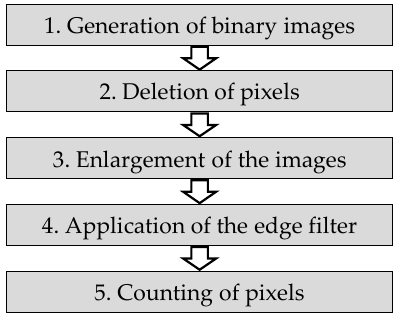
Figure 2. Steps of the developed SEM image evaluation algorithm.